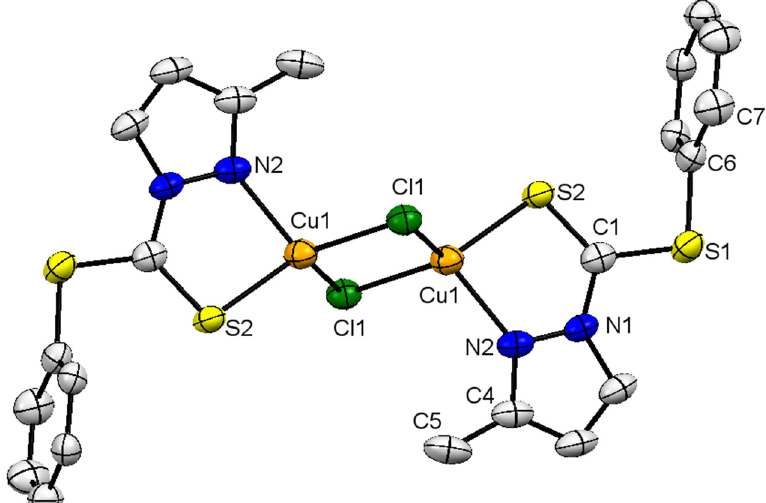
Figure 3. Solid-state molecular structure of 2 ; partial-numbering scheme, thermal ellipsoids are drawn at 50% probability level, for clarity reasons all hydrogen atoms are omitted. Color scheme: Cu = orange; Cl: green; S = yellow; and N = blue. Selected structural features: bond lengths (Å) and angles (°); Cu(1)-N(2) 2.054(3), Cu(1)-S(1) 2.281(9), Cu(1)-Cl(1) 2.317(9), Cu(1)-Cl(1) 2.338(9), Cu(1)-